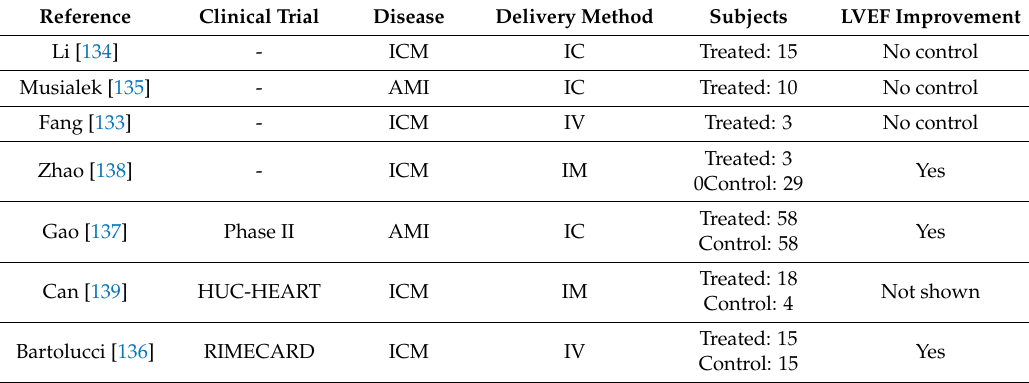
Table 7. Clinical trials with UC-MSCs for cardiac